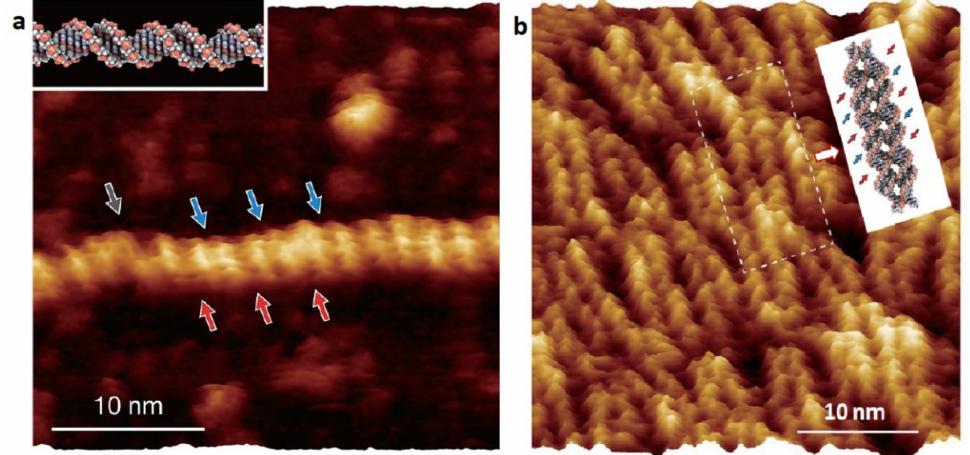
Figure 3. High-resolution FM-AFM topographic images of ( a ) the B-DNA plasmid and ( b ) the 2D DNA tile structure in aqueous solution of 50 nM NiCl 2 . Well-resolved positions of major and minor grooves are marked with red and blue arrows respectively. ( a ) The damaged intersection is marked by the gray arrows. A model molecular structure of the B-DNA is shown in the inset. ( b ) A theoretical model of the DNA tile unit with four branches (two at top of the unit and two at the bottom) corresponding to the image area indicated by the white rectangle is shown in the upper right corner of the panel. Composed from original figures reproduced with permission from Ido, S.; ACS Nano ; published by ACS Publications,